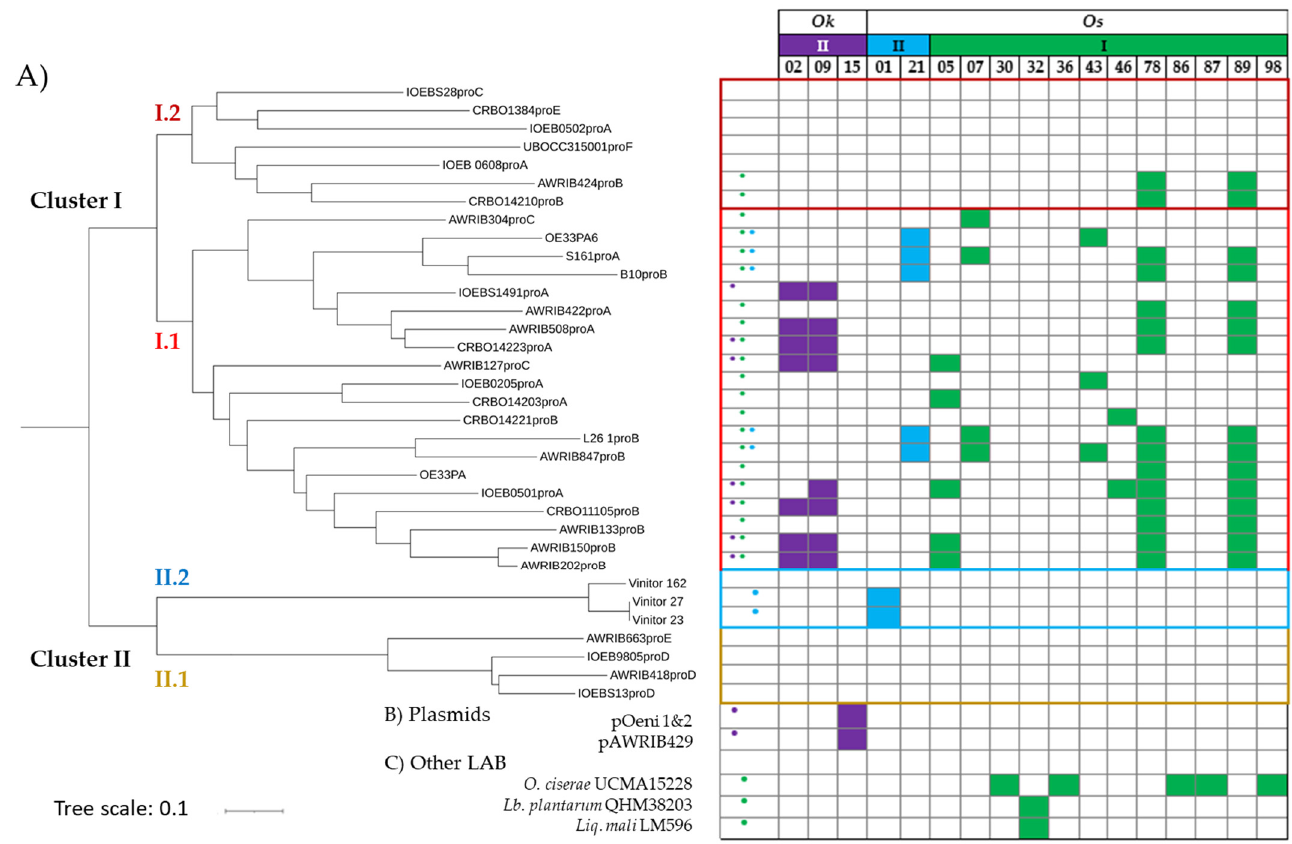
Figure 3. Distribution of the protospacers in oenophages. ( A ) Phylogenetic tree of the 34 phages of O. oeni , including OE333PA (ex-temperate), OE33PA6 (temperate) and Vinitor (strictly lytic), which were isolated as free replicating phage particles from must or wine samples. Other genomes correspond to prophages, and reference to their cognate integrase group was also added, since many lysogens harbour two or three prophages belonging to distinct integrase groups. In the leftward column, dots were used to summarize the presence of protospacers targeted by the CRISPR of O. kitaharae (purple) or O. sicerae (blue and/or green); ( B ) presence of spacers in plasmids of O. oeni ; ( C ) presence of spacers in the genome of other LAB. Lb. plantarum , Lactiplantibacillus plantarum ; Liq. mali , Liquorilactobacillus mali .